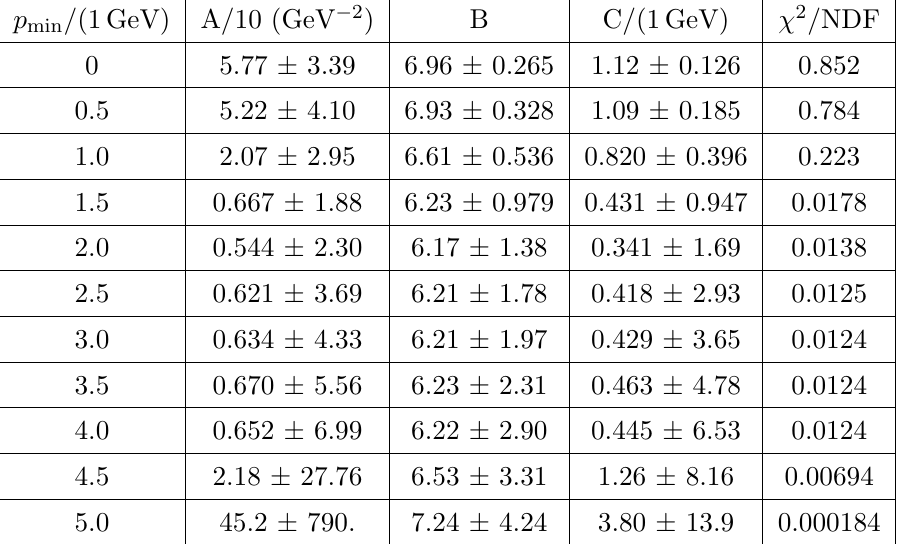
Table 5. Fitted values of parameters in eq. (E.3) for the ATLAS dataset at p s = 13 TeV [94].